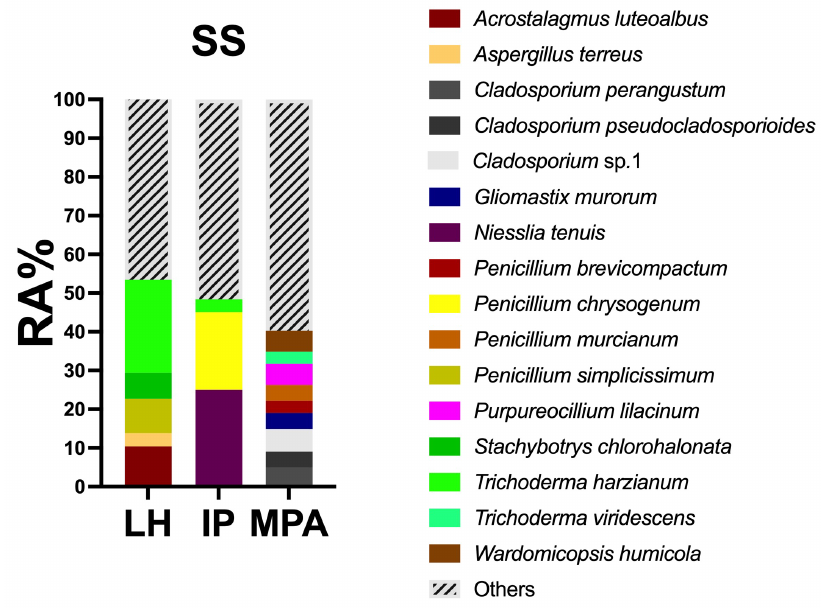
Figure 3. Relative abundance (RA%) of SS fungal taxa for Livorno harbor (LH), intermediate point (IP), and marine protected area (MPA). Fungal taxa with RA% < 3% are grouped in “others”.